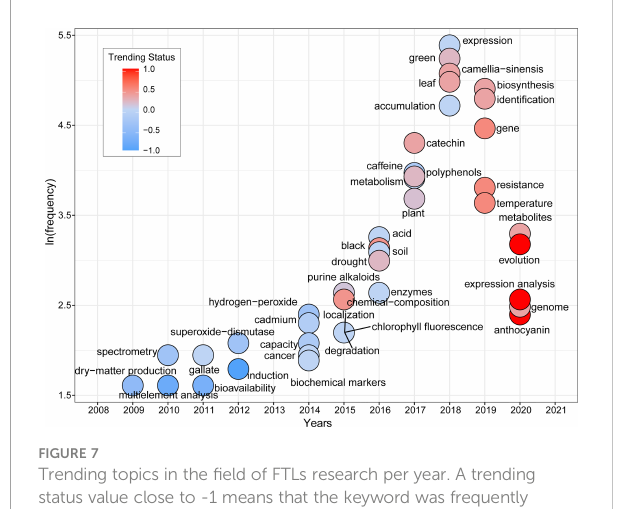
FIGURE 7 Trending topics in the fi eld of FTLs research per year. A